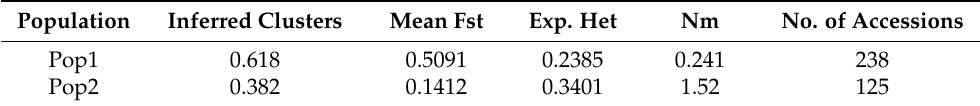
Figure 3. Population structure of the 363 Afghan bread wheat landraces. Table 2. The STRUCTURE results of 363 Afghan landraces for the fixation index (Fst), average distances (expected heterozygosity/Het), gene flow (Nm), and the number of accessions assigned to each